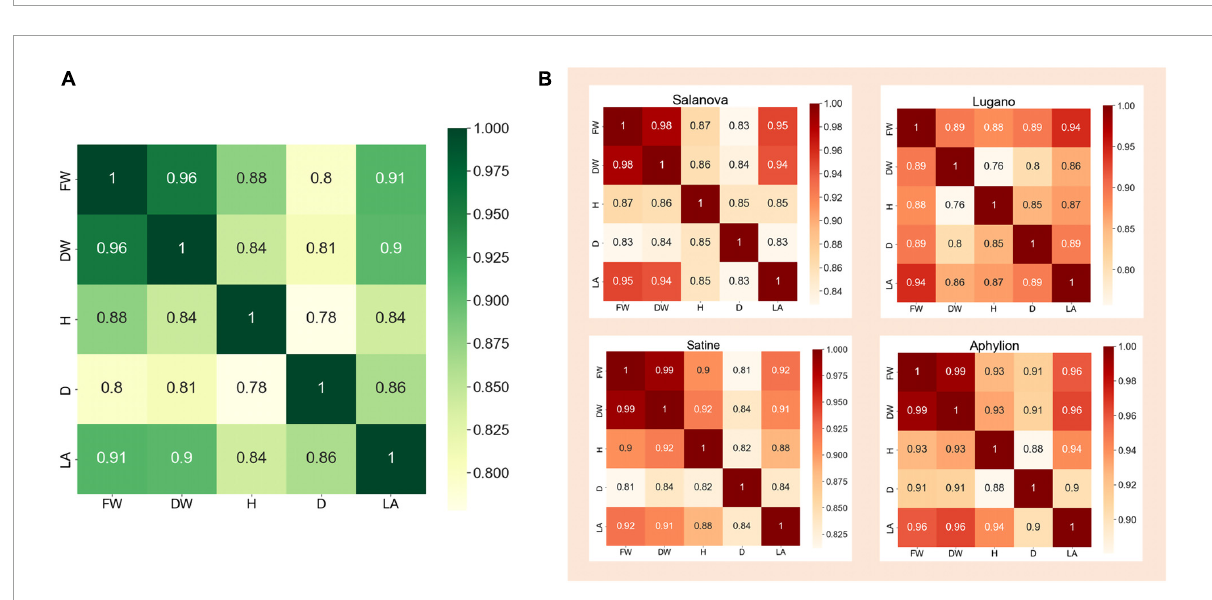
FIGURE3 The heat map of correlation analysis of different traits. (A) Correlation analysis of all samples. (B) Correlation analysis of four lettuce varieties on their